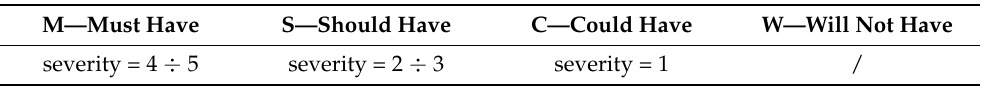
Table 2. Association of the priority MoSCoW scale with the levels of severity. M—Must Have S—Should Have C—Could Have W—Will Not Have severity = 4 ÷ 5 severity = 2 ÷ 3 severity = 1